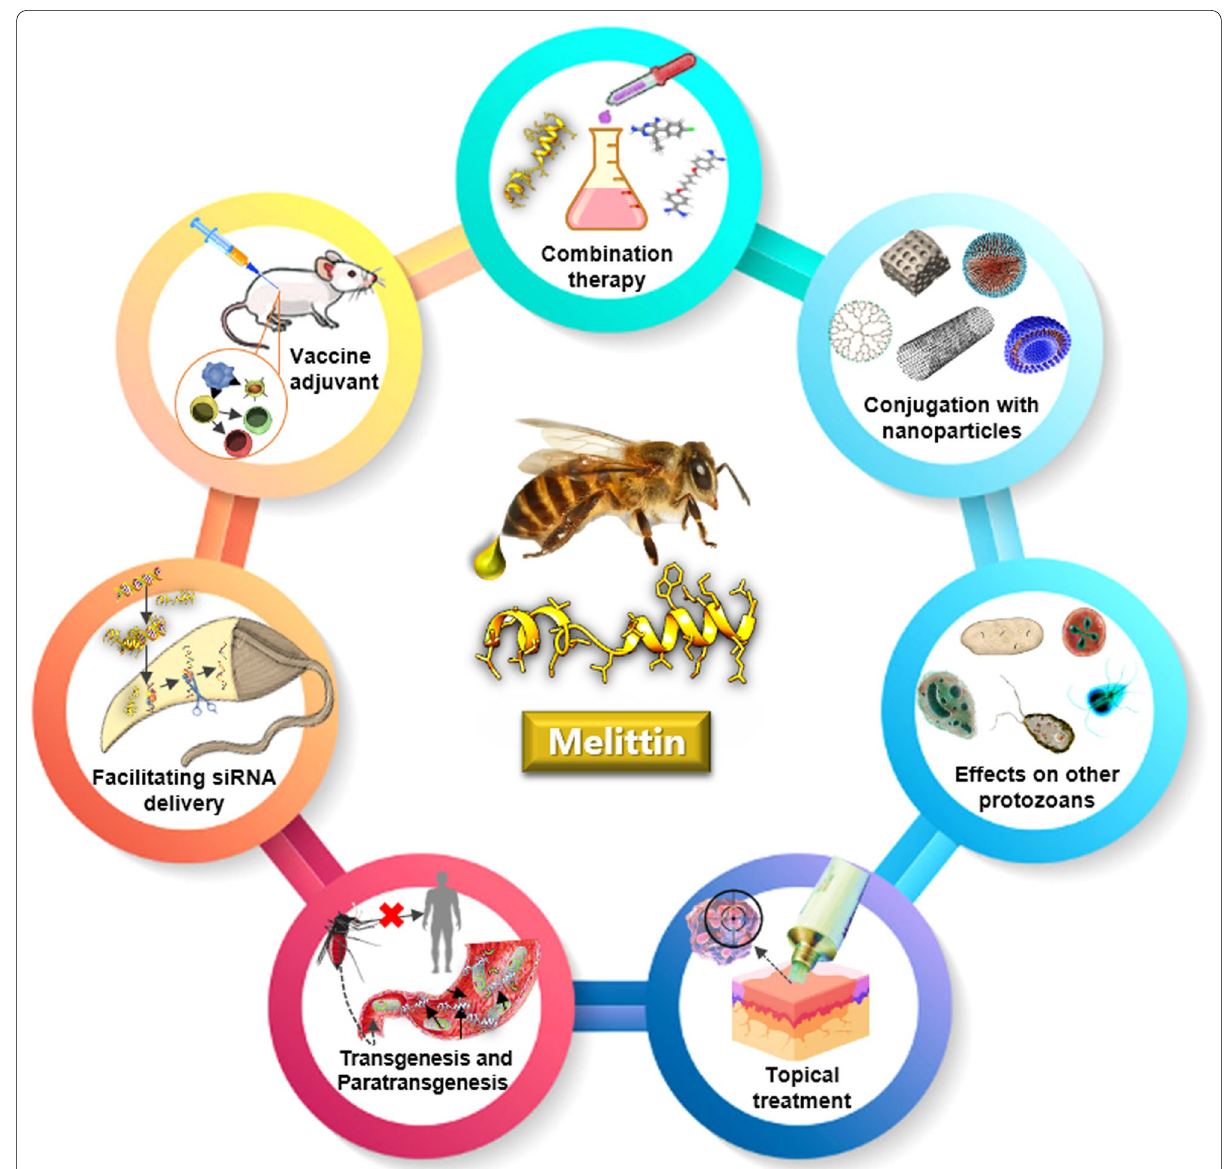
Fig. 1 Potential biomedical applications of melittin for future studies on protozoan